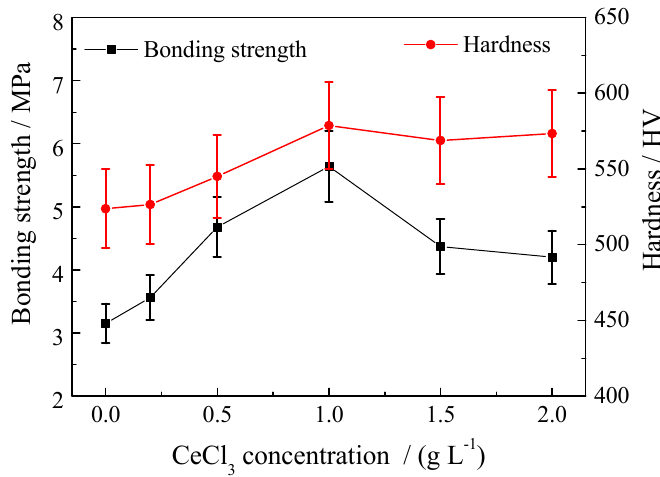
Figure 3. The micro-hardness and adhesive strength of the Pd-Ni alloy film that was obtained at different contents of CeCl 3 in the electroplating solution.